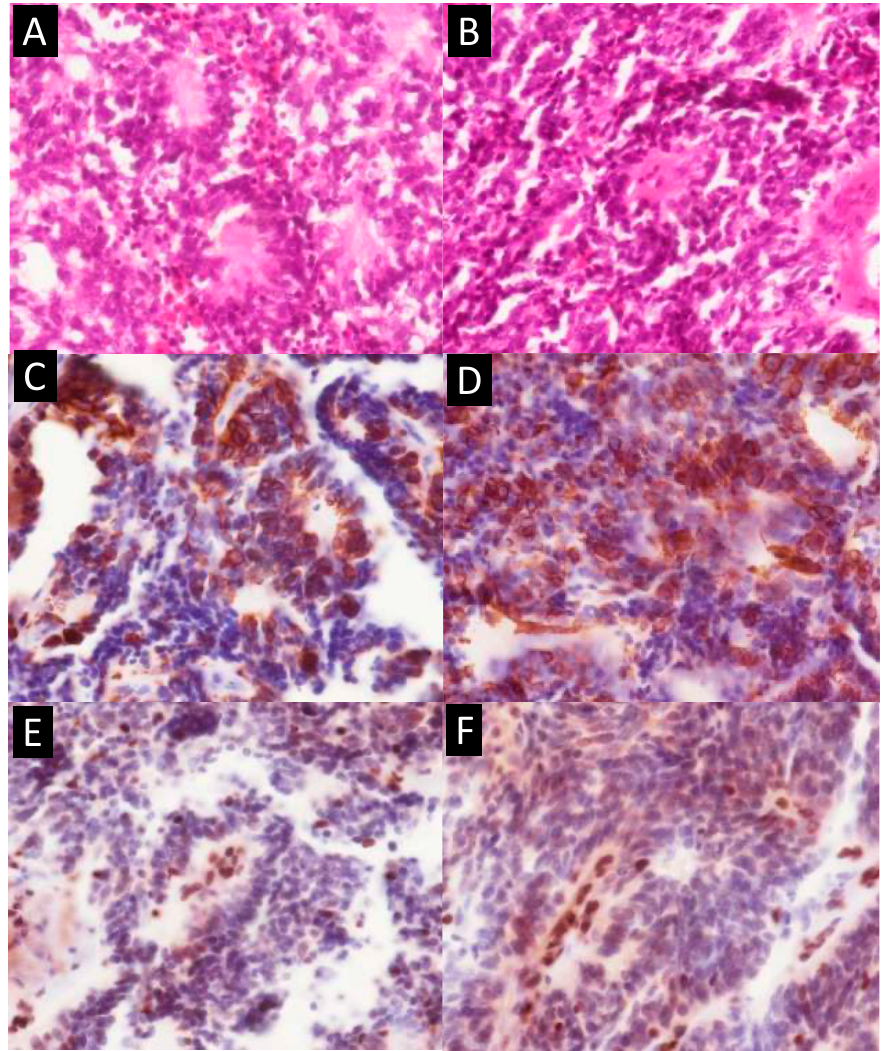
Figure 2. Primary and recurrent ependymomas of the posterior fossa, type A (EPN-PFA). ( A , B ) The neoplastic cells form perivascular pseudorosettes and ependymal rosettes in the primary ( A ) and recurrent ( B ) tumors (400 × magnification). ( C , D ) Immunohistochemical stain for GFAP in the primary ( C ) and recurrent ( D ) tumors (400 × magnification). ( E , F ) The tumor cells lost the expression of H3K27me3 (compared with the vascular endothelium cells as internal control) in the primary ( E ) and recurrent ( F ) tumors (400× magnification).